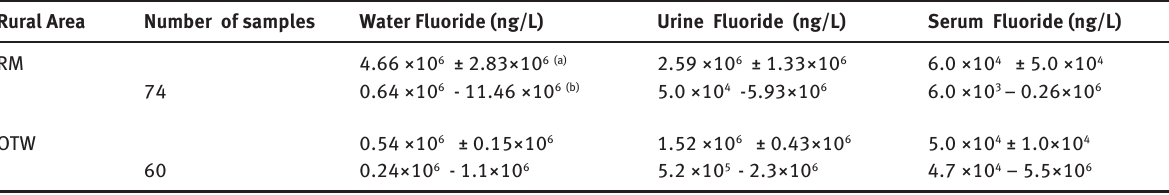
Table 1: Level of Fluoride in Water, Urine and Serum of Children from RM and OTW. Rural Area